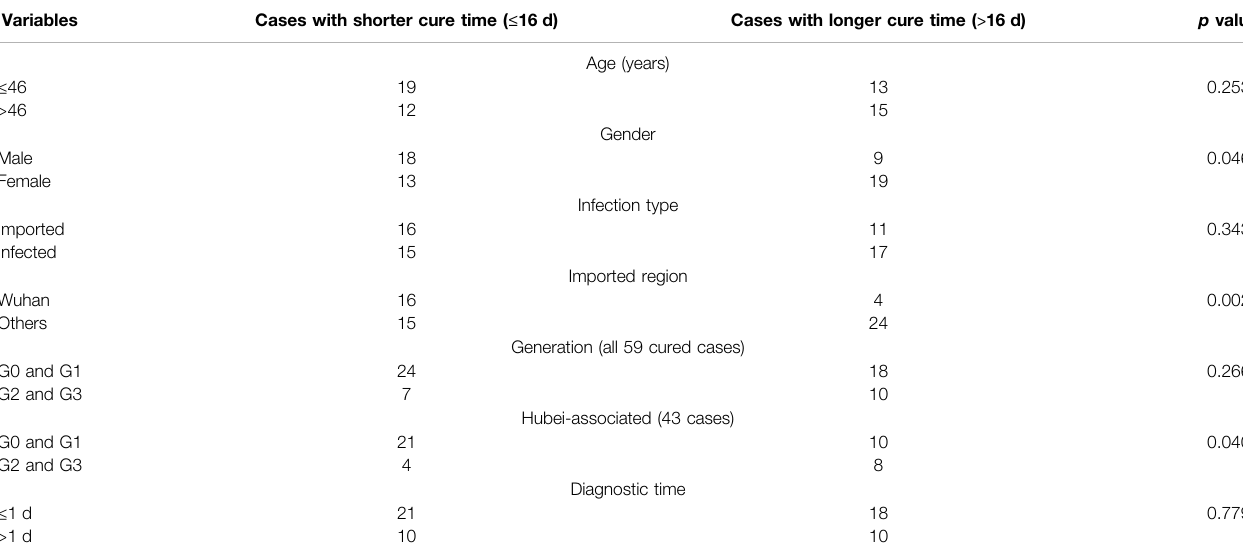
TABLE 2 | Correlation analysis of therapeutic ef fi ciency in cured COVID-19 patients in Qingdao ( N (cid:1) 59). Variables Cases with shorter cure time ( ≤ 16 d) Cases with longer cure time ( > 16